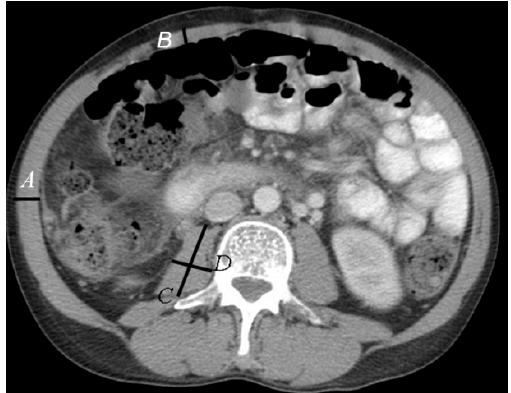
Figure 2. Assessment of muscle wasting at the third lumbar vertebra (L-3). Cross-sectional psoas muscle area measured using computed tomography imaging (CT) at the level of the third lumbar vertebra: A: lateral wall muscle measurement; B: abdominal wall muscle 2 cm to the right of the midline ; C: anterior/posterior length measurement; D: transverse psoas diameter.